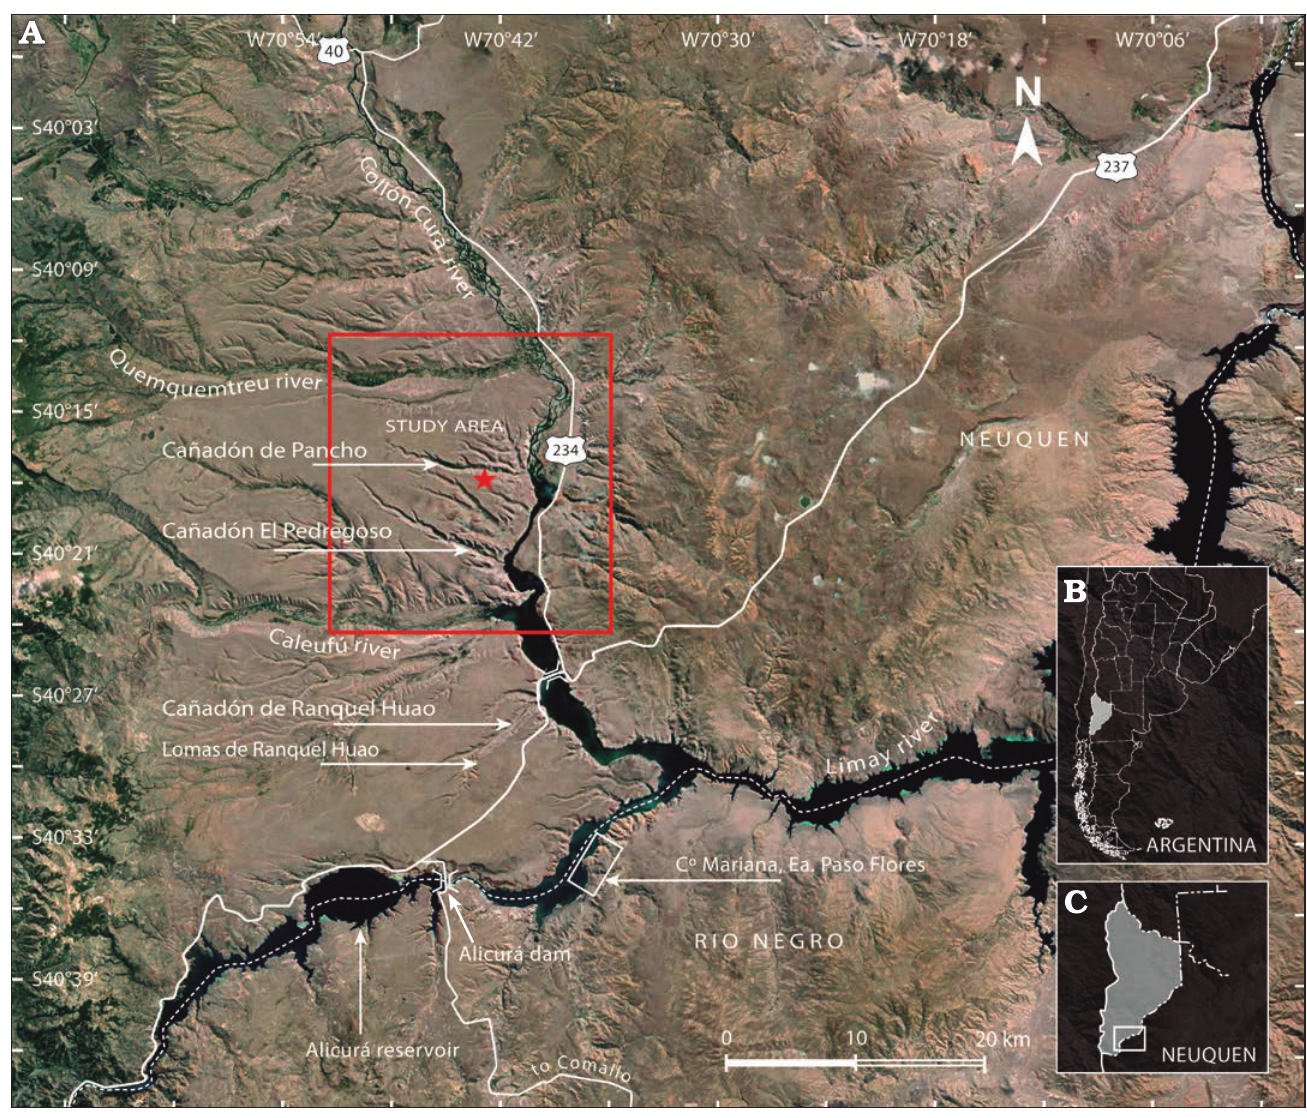
Fig. 2. Location of the study area within Argentina and southern region of the Neuquén Province and north-western region of the Río Negro Province ( B , C ). Aerial view of the study area showing the main outcropping sections of the Paso Flores Formation ( A ) (based on Spalletti et al. 1988 and González Díaz 1982). The star indicates the location of the studied fossil flora at Cañadón de Pancho described herein. Image taken from Google Earth